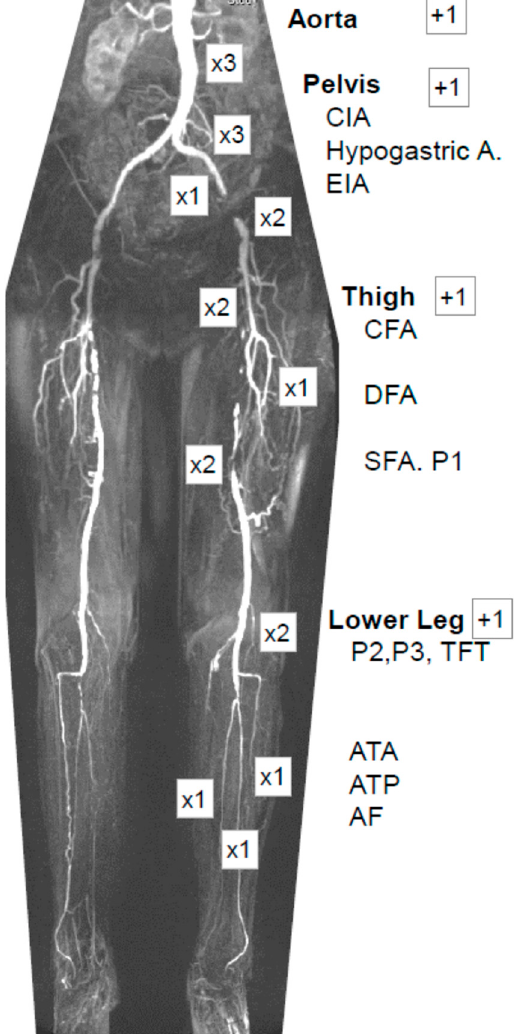
Figure 1. Multiplanar reconstruction of an MR-A of a patient with severe arterial disease. The main levels constituting the modified runoff resistance score (mROR) are the infrarenal aorta, pelvis, thigh, and lower leg. Each vessel is graded by the degree of stenosis (1 for 20–49% stenosis, 2 for 50–99% stenosis, 2.5 for occlusion of less than half the length, and 3 for occlusion of more than half the length of the vessel) and multiplied with its weighting factor depicted. For each main level, 1 is added as the physiologic runoff resistance. CIA: common iliac artery; EIA: external iliac; CFA: common femoral; DFA: deep femoral; SFA: superficial femoral arteries; P1, P2, P3: popliteal artery, segments 1–3; TFT: tibiofibular trunk; ATA: anterior tibial; ATP: posterior tibial; AF: peroneal artery.